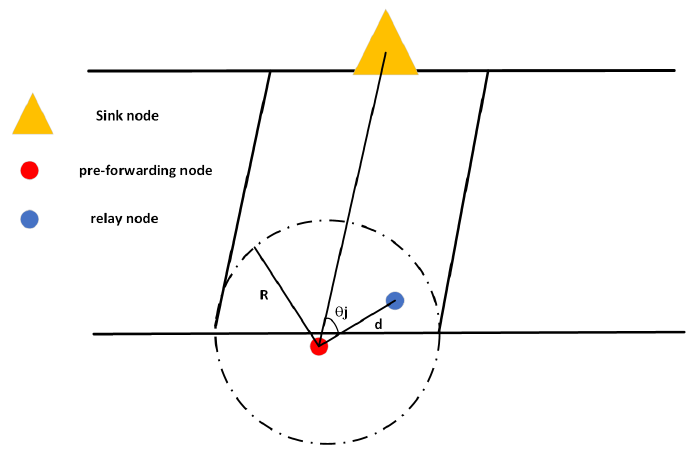
Figure 3. The schematic diagram of PDDQN-HHVBF